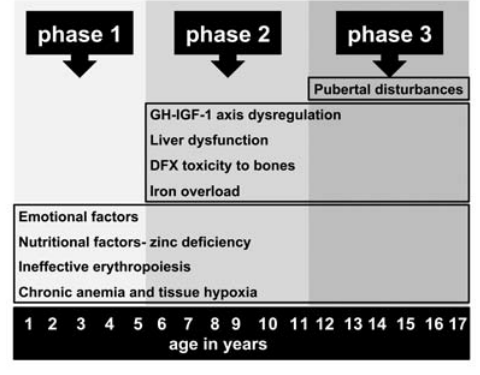
Figure 1. Three phases of growth according to age of presen- tation, which have different causes – the multifactorial origin of growth failure in